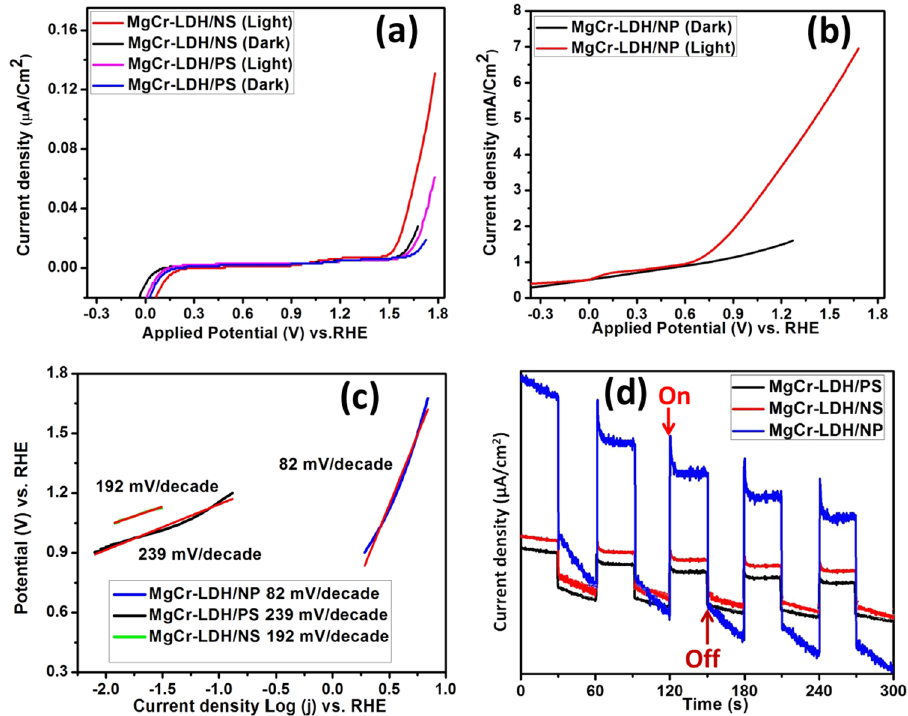
Figure 6. ( a , b ) Dark and light current density of MgCr-LDH/PS, MgCr-LDH/NS and MgCr-LDH/NP via LSV plot, ( c ) Tafel slope plot of MgCr-LDH/PS, MgCr-LDH/NS and MgCr-LDH/NP and ( d ) Transient photocurrent density of MgCr-LDH/PS, MgCr-LDH/NS and MgCr-LDH/NP measured through light on–off